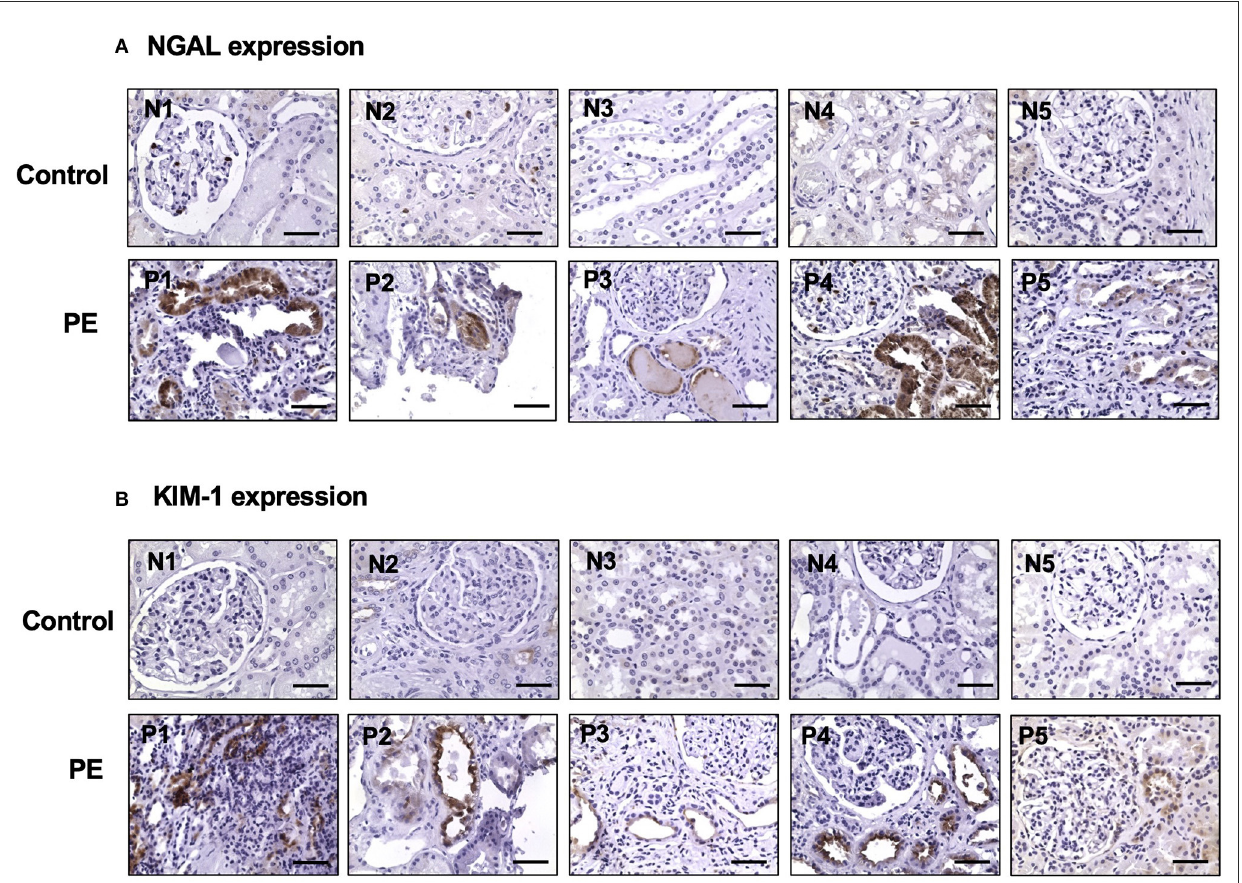
FIGURE2 Upregulation of NGAL and KIM-1 expression in kidney tissue specimens from women with preeclampsia. NGAL and KIM-1 expression was detected in proximal tubule epithelial cells in kidney specimens from women with preeclampsia but not in control cases. Representative images of NGAL (A) and KIM-1 (B) expression from each of the control (N1 to N5) and preeclamptic (PE) (P1 to P5) cases, respectively. Magnification is x40 and the scale bar = 50